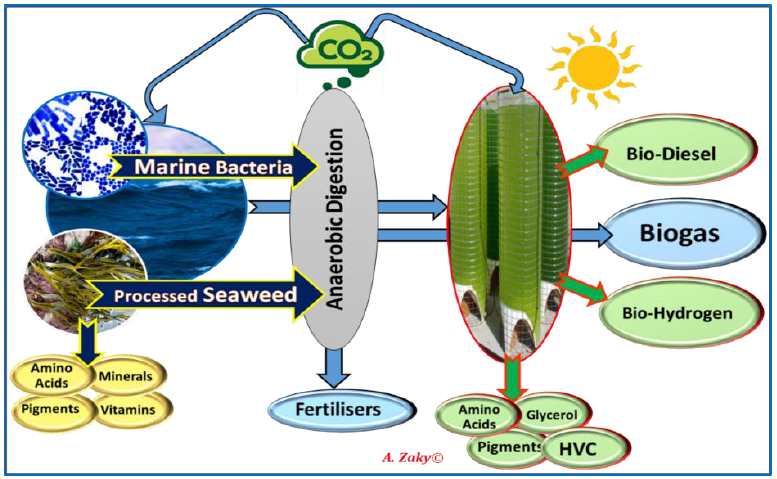
Figure 7. Coastal integrated marine biorefinery (CIMB) system (Route 1).